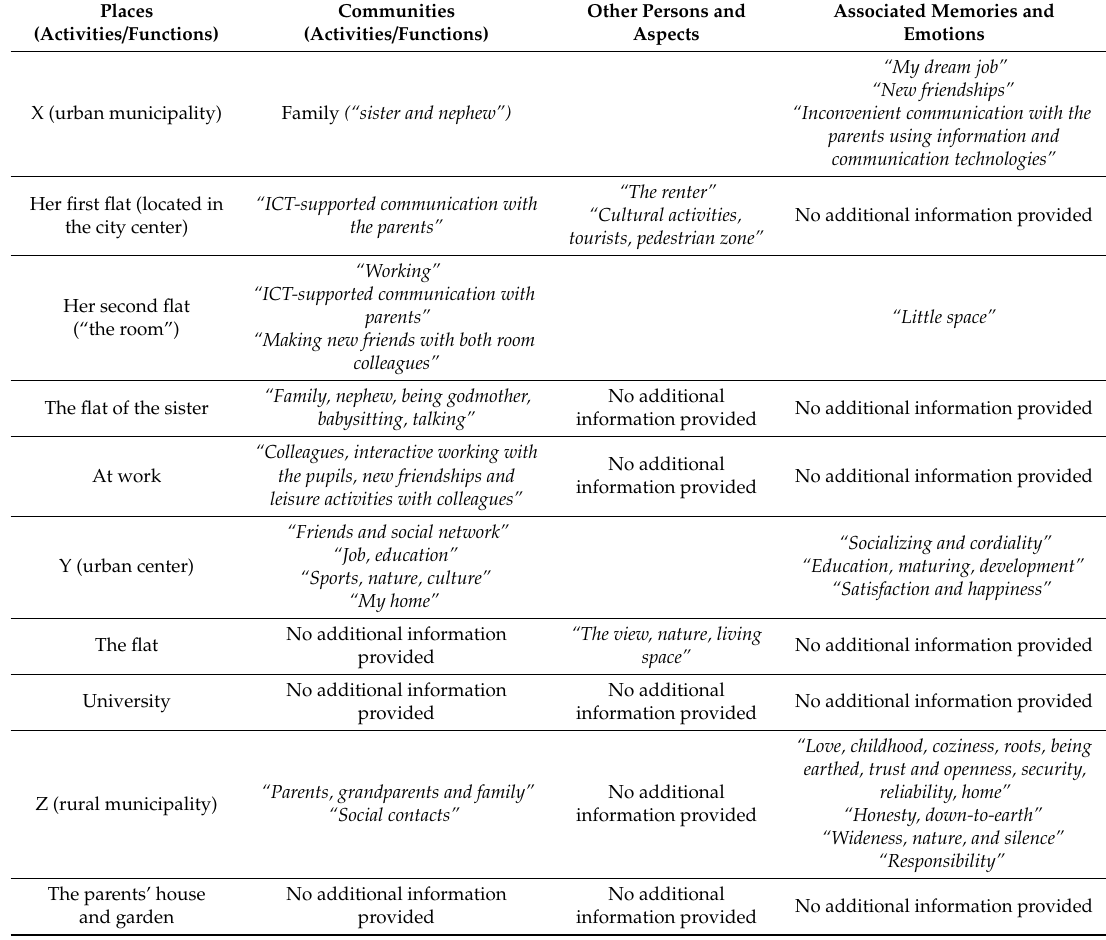
Table A1. Spatial scatteredness of life and place related